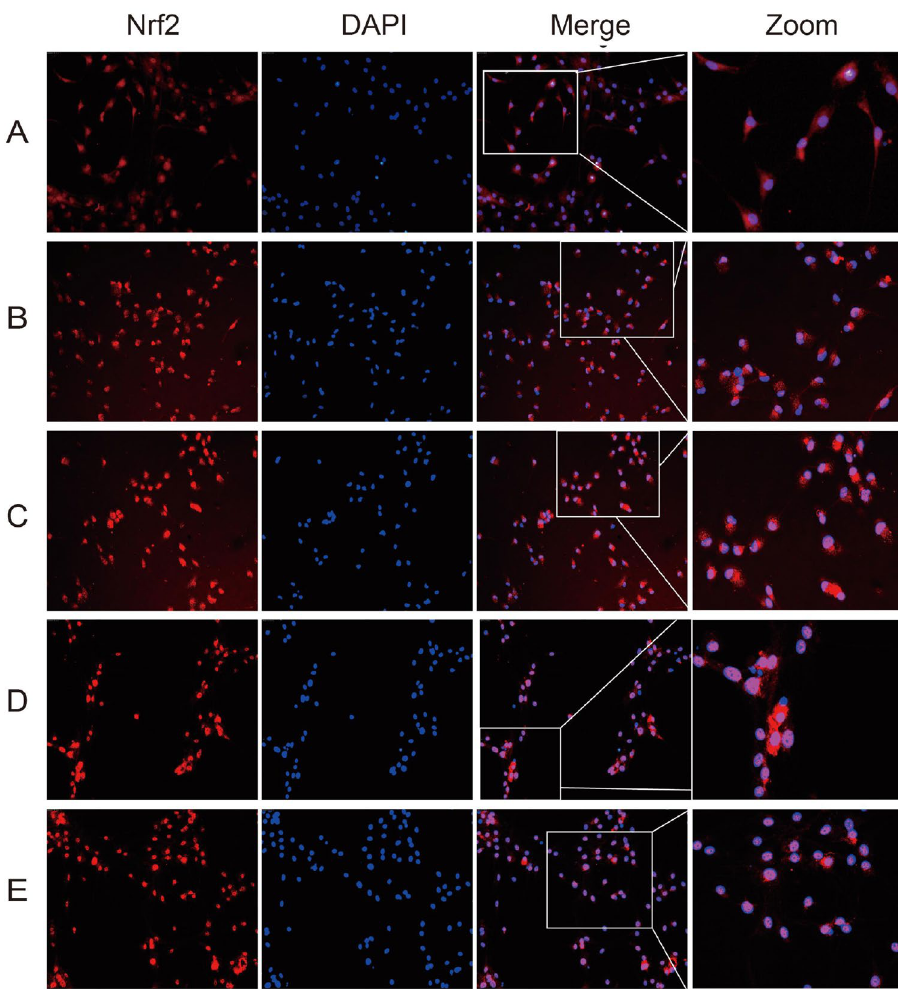
Figure 6. The effect of IMP on the nuclear translocation of Nrf2 protein in CoCl2-induced hypoxia in hippocampal neuronal cells (× 400). Red fluorescence is positive staining for Nrf2 protein, indicating the expression of Nrf2 protein, and blue fluorescence is DAPI staining, indicating cell nucleus. Emerge image is a fusion image of Nrf2 protein and cell nucleus for positioning. The Zoom image is a magnified image randomly selected from the emerge image to observe the Nrf2 positioning. ( A ) Normal group, ( B ) CoCl2 treatment group, ( C ) CoCl2 + 5.0 μmol/l IMP, ( D ) CoCl2 + 7.5 μmol/l IMP, ( E ) CoCl2 + 10.0 μmol/l